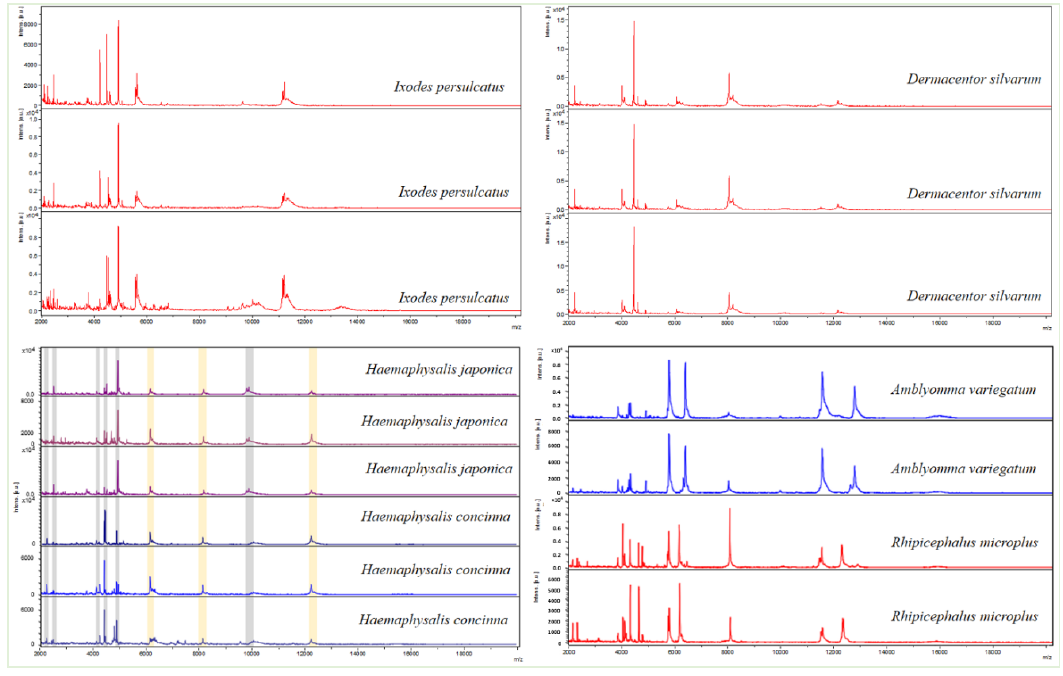
Figure 3. MS spectra profiles of female and male tick species using the new “rehydration” protocol. Species and genus-specific spectra are respectively indicated in grey and yellow colons for Haemaphysalis